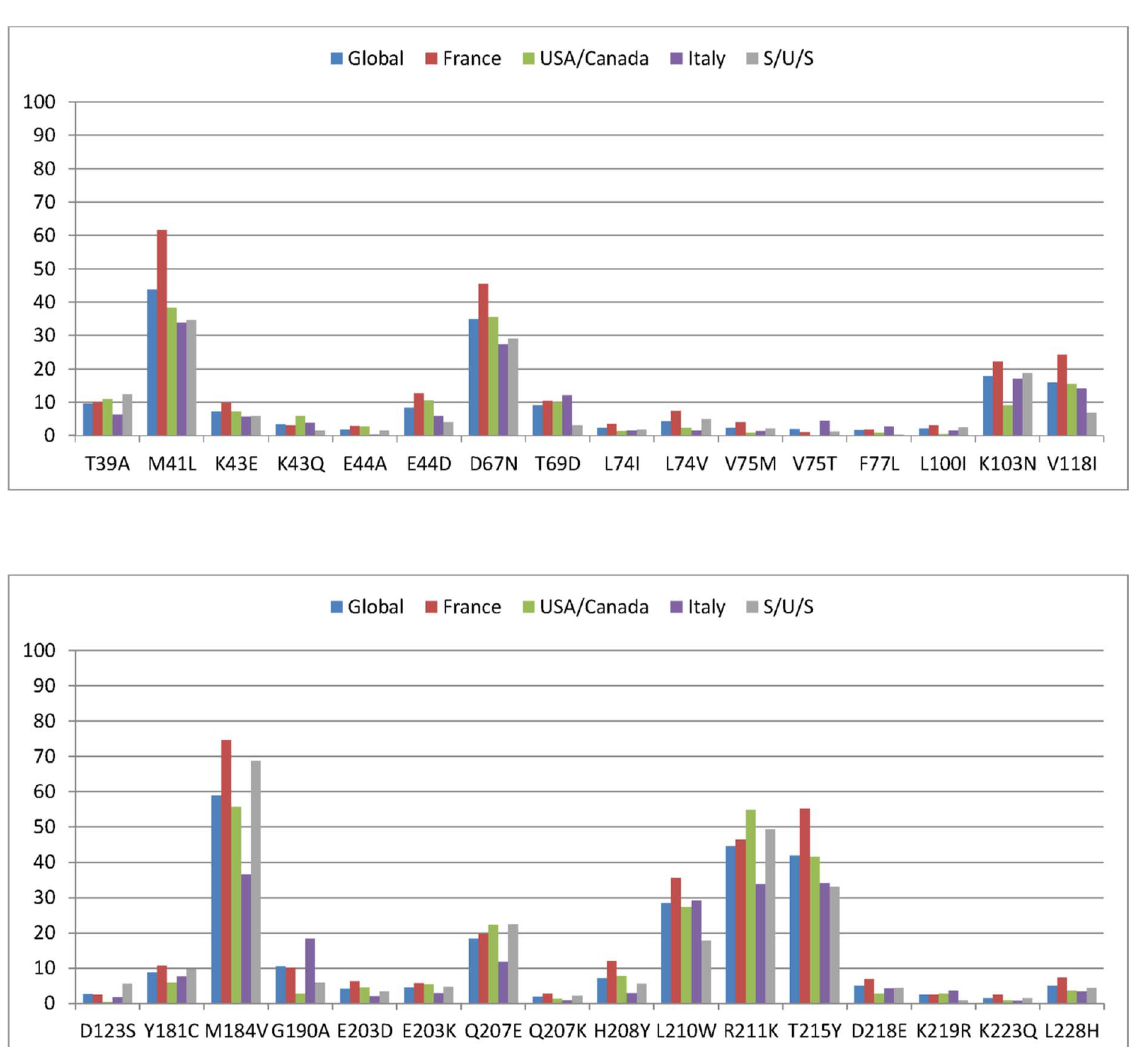
Figure 1. Frequency of the 32 mutations retained in the analysis on the entire data set and by country-based data sets.